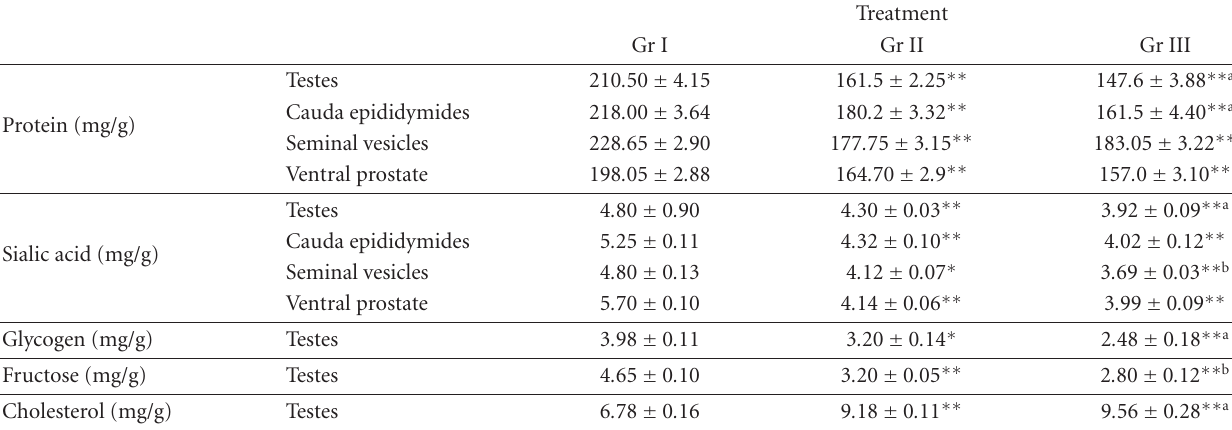
Table 5: E ff ects on certain biochemical parameters following the treatment of compounds 1 and 2 (values are mean ± SEM ( n = 6)).